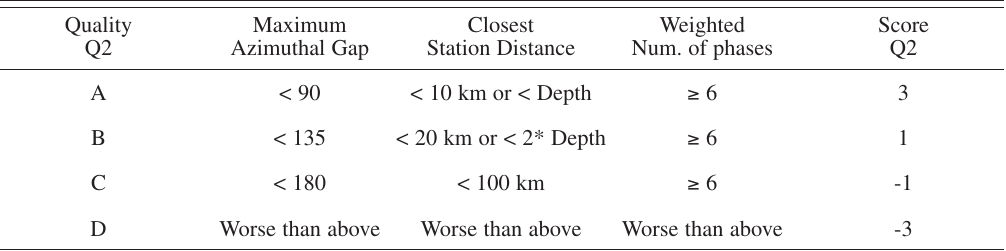
Table IV. Quality Ranking Q2 used to class hypocenters according to station geometry and distance of the closest station from the epicenter. An earthquake has quality D if at least one of the conditions is not verified.